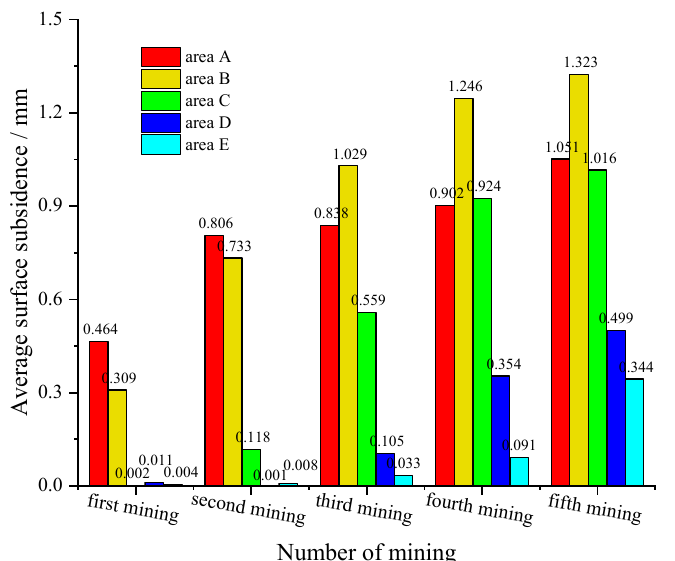
Figure 12. Histogram of average sediment volume change in different regions of the surface.